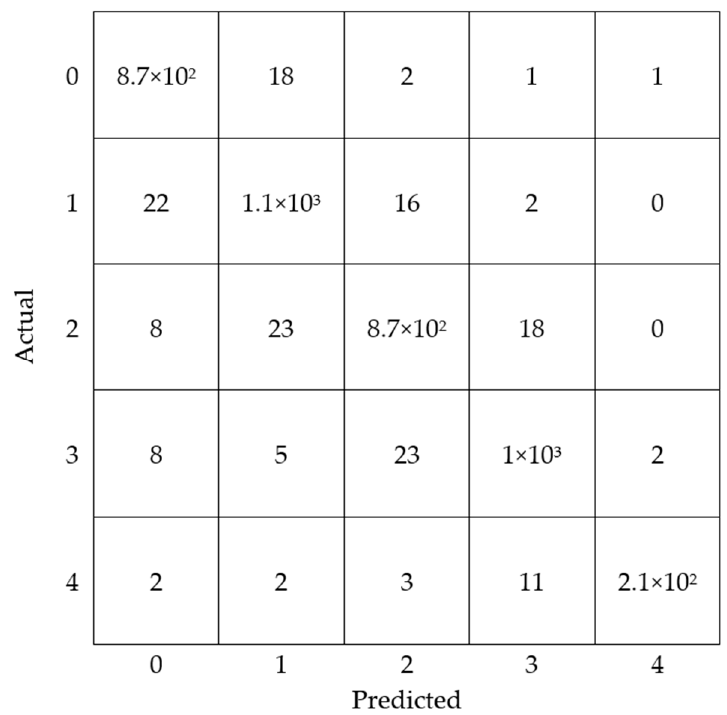
Figure 7. Confusion matrix of hierarchical fusing (HF)-RF floor classification.